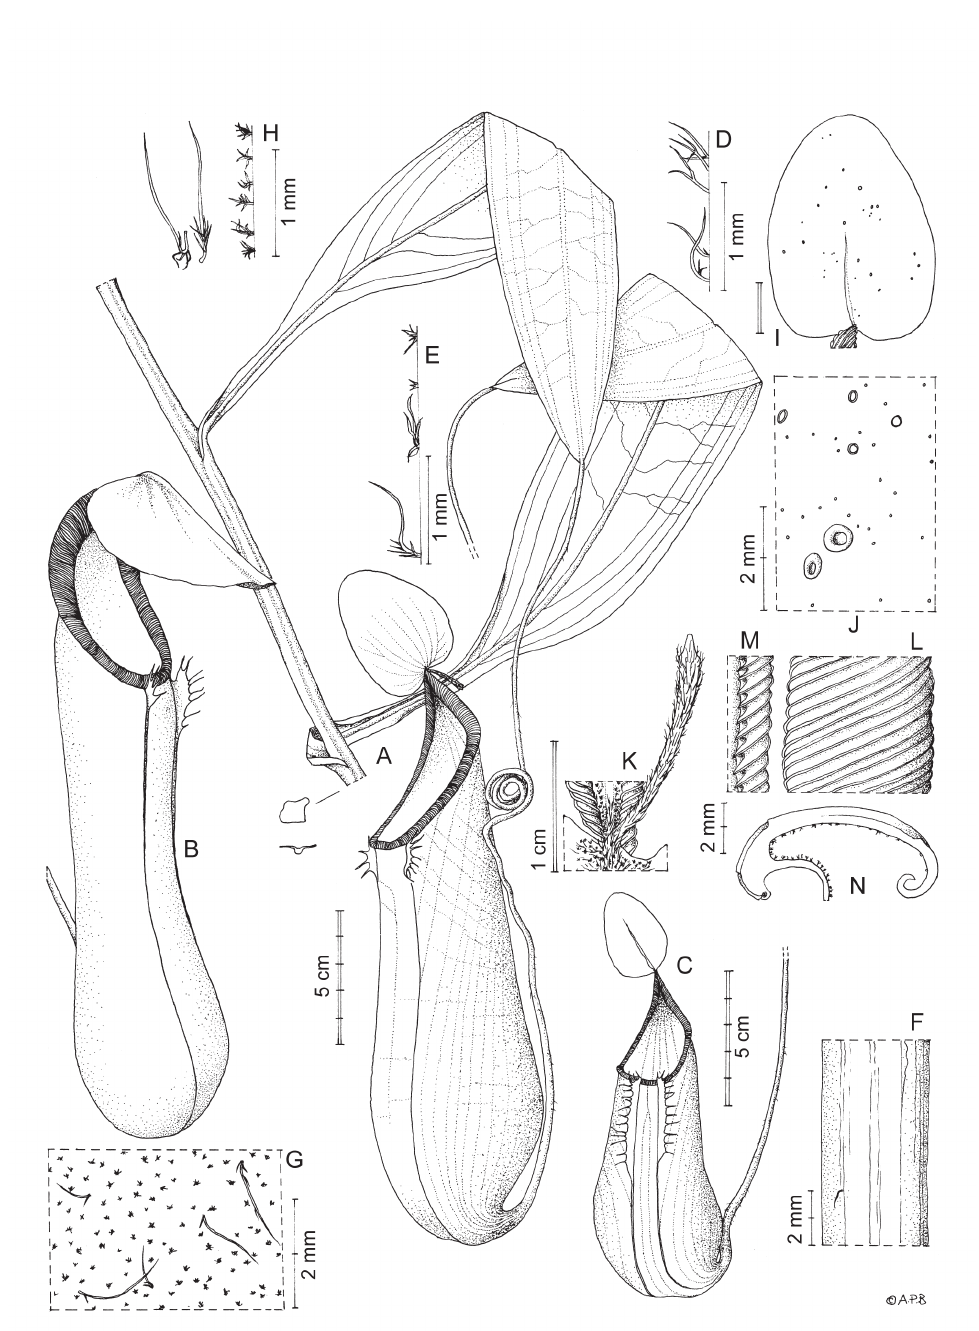
Fig. 2. Nepenthes kitanglad sp. nov. A . Habit, climbing stem with upper pitcher (from herbarium specimen). B . Upper pitcher (from live plant). C . Lower pitcher. D . Indumentum from leaf margin. E . Indumentum from tendril. F . Indumentum from stem (extremely sparse hairs). G . Indumentum of outer pitcher surface, plan view. H . Ibid. , profile view. I . Lower surface of lid (upper pitcher). J . Detail of glands from lower surface of lid. K . Spur of upper pitcher. L . Peristome, upper pitcher, view from above. M . Peristome, view from inside of pitcher, showing minute teeth. N . Peristome, transverse section (outer surface on right). A, D–N from Gaerlan et al . in PPI 3274 (BISH); B from McPherson (2009: Fig 417); C from Gaerlan et al. in PPI 3274 (BRIT). Scale bars: double = 1 cm; double graduated = 5 cm; single = 1 mm; single graduated = 2 mm. All drawn by Andrew